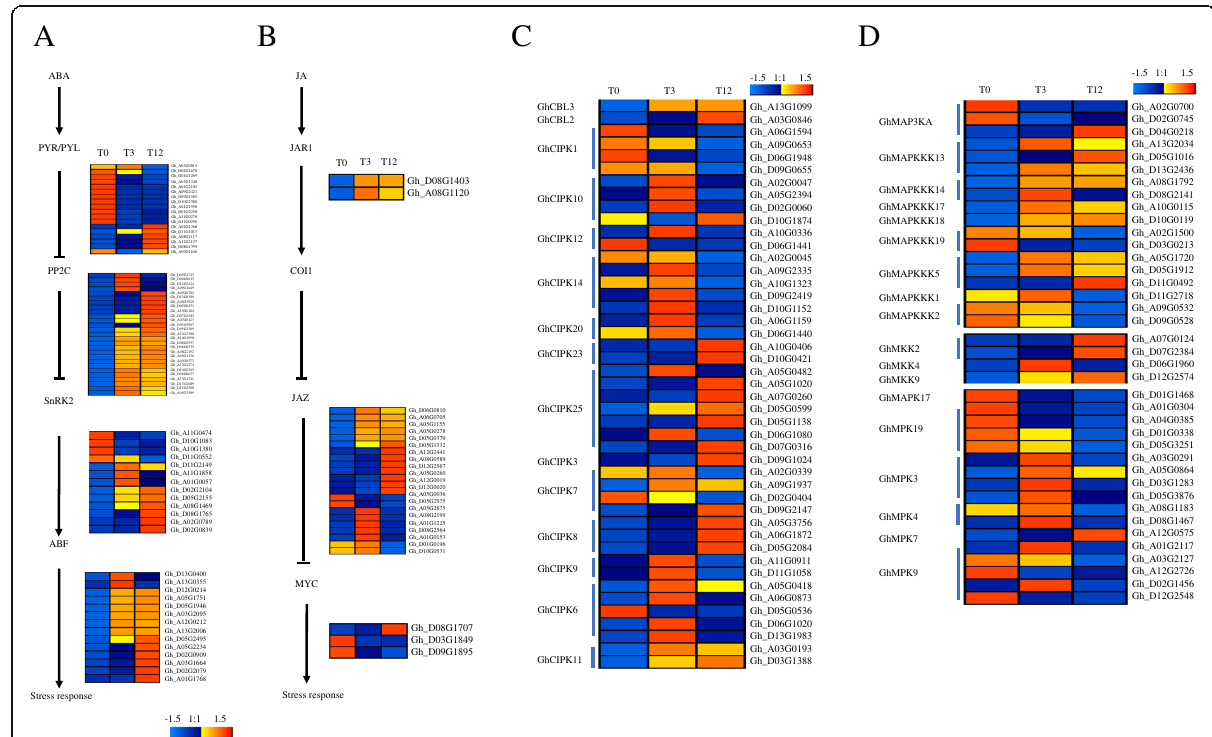
Fig. 4 Plant signal transduction in response to salt stress in cotton. a - b The expression patterns of genes which were involved in ABA and JA signal pathways. c The expression patterns of CBL and CIPK genes. d The expression patterns of MAPK signaling cascade